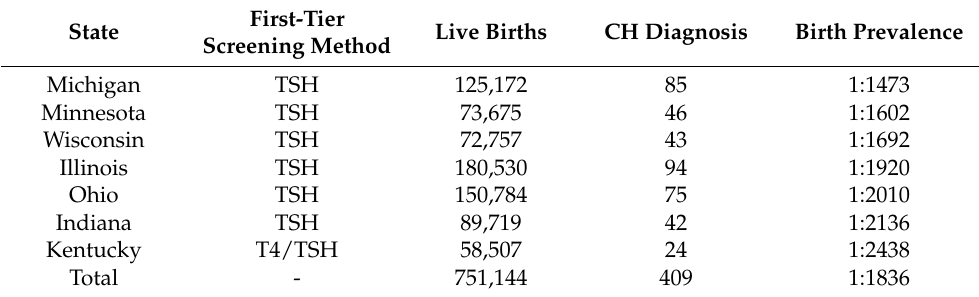
Table 1. Newborn screening and CH birth prevalence in Region 4 for